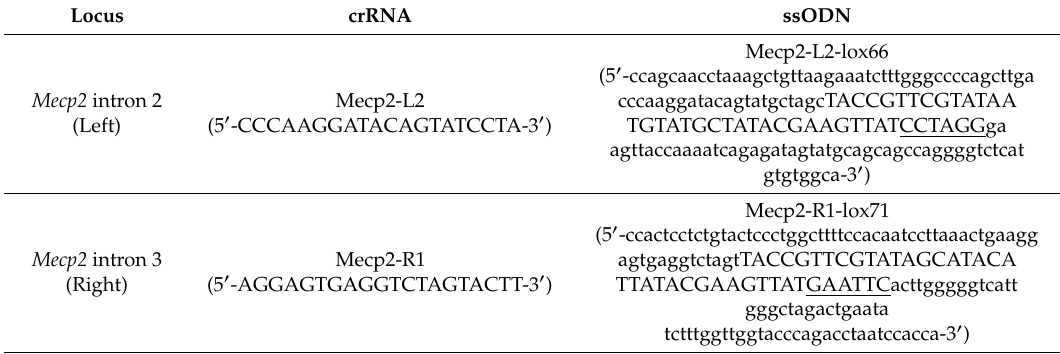
Table 1. crRNA and ssODN used in this